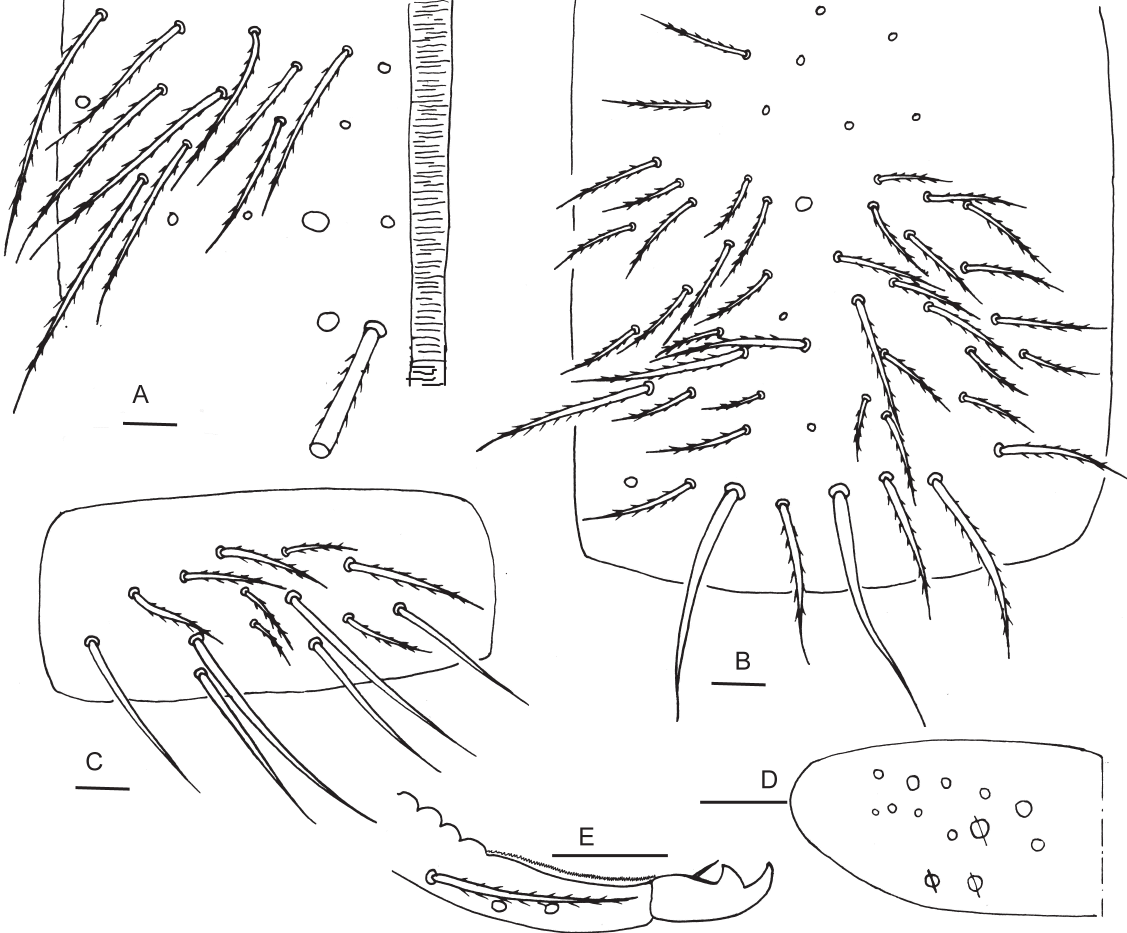
Fig. 5. Entomobrya leviseta sp. nov. A . Anterior face of ventral tube. B . Posterior face of ventral tube. C . Lateral flap of ventral tube. D . Plaque of manubrium. E . Distal part of dens and mucro. Scale bars: A–E = 20